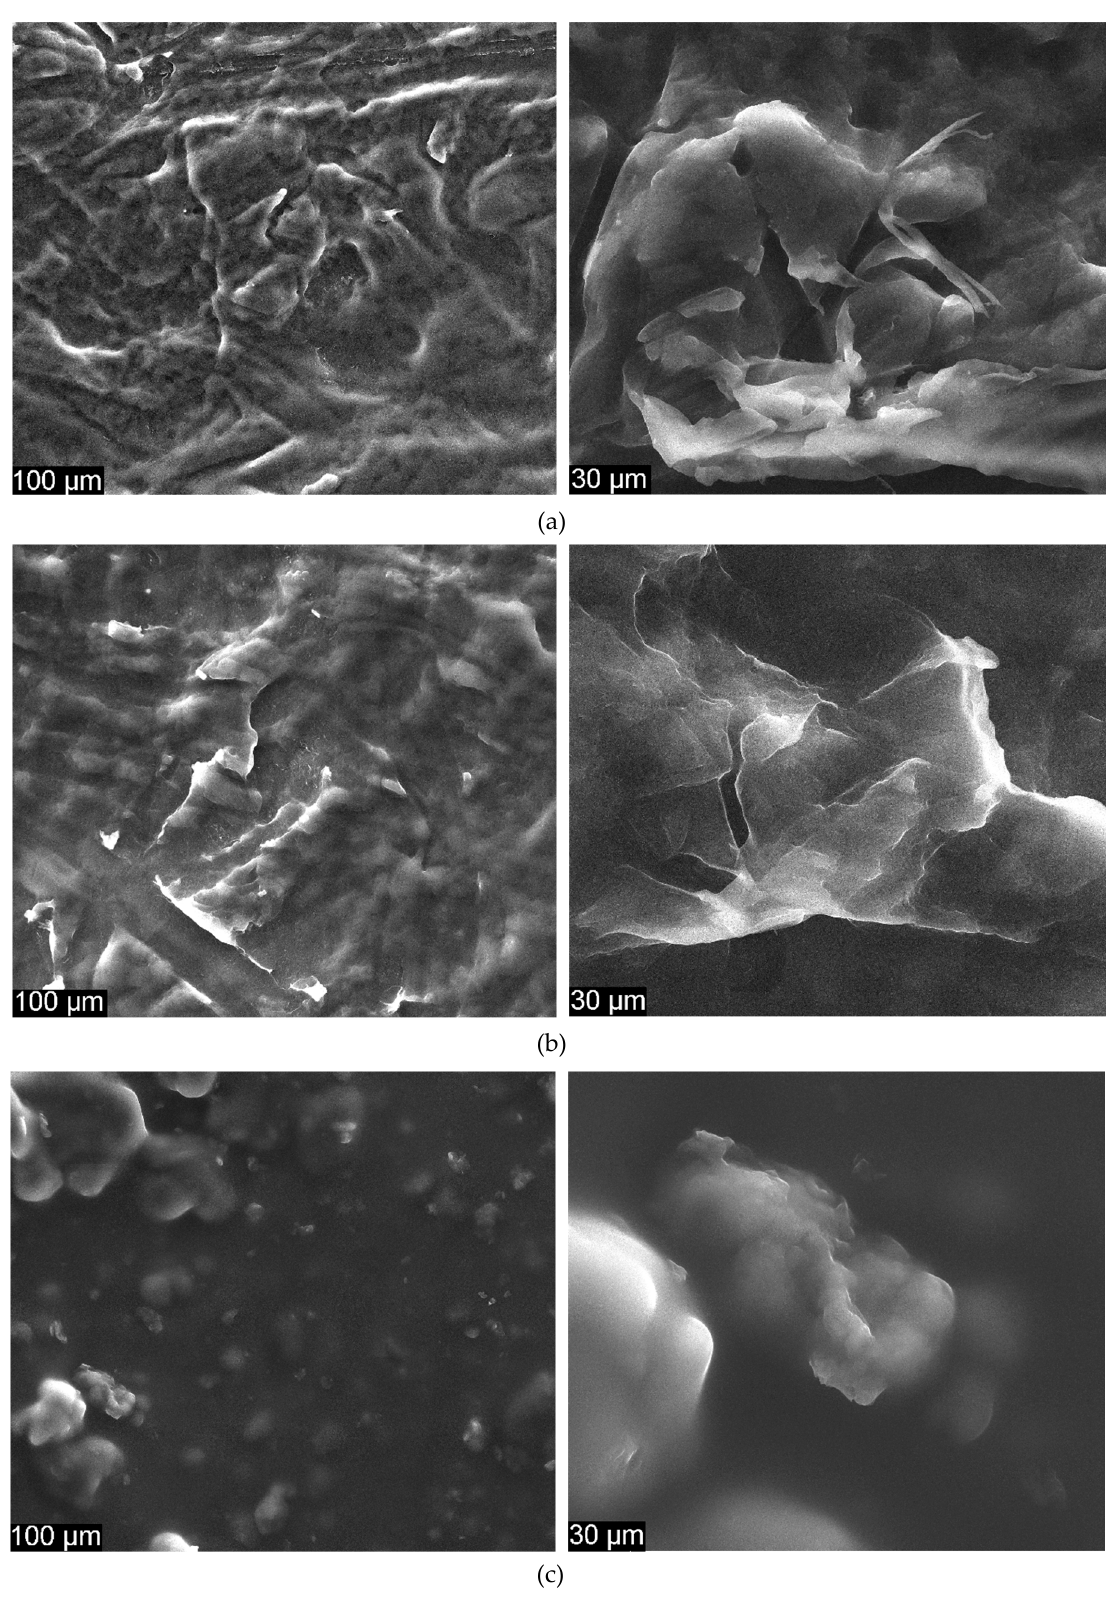
Figure 6. SEM images for ( a ) CS/EDTA, ( b ) CS/EDTA/GO 0.1% and ( c ) CS/EDTA/GO 0.3% at 1000 × (left) and 5000 × magnification (right).